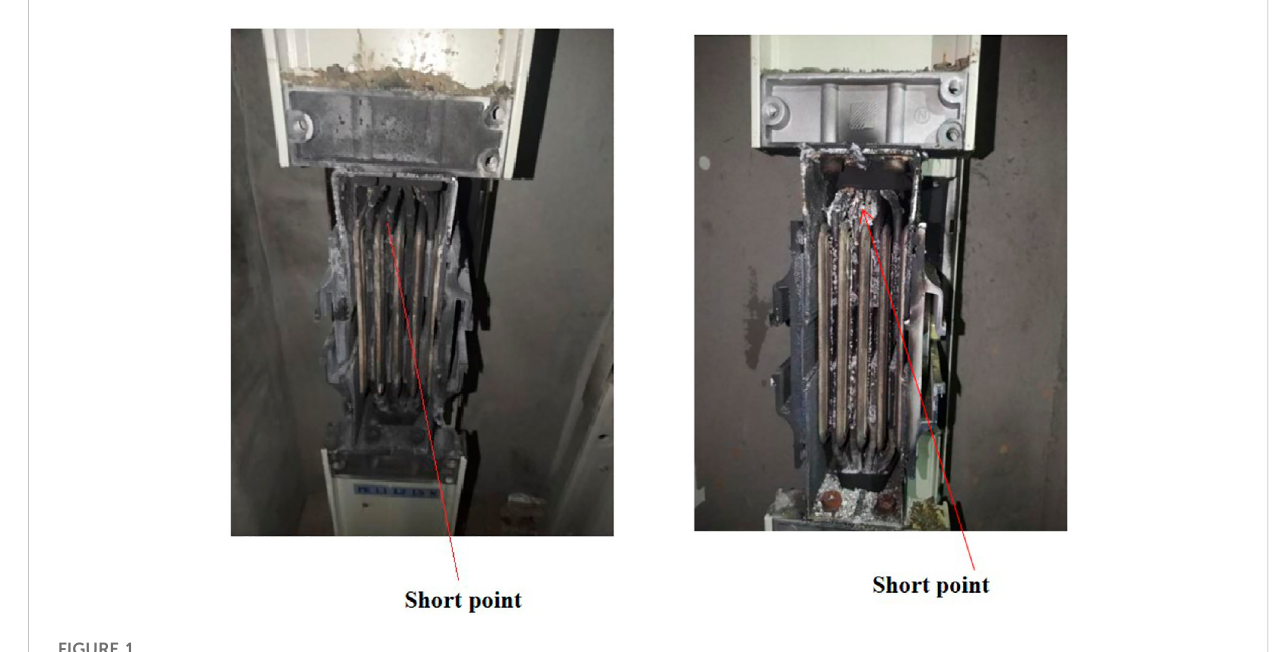
FIGURE 1 Fault busways with short circuit in